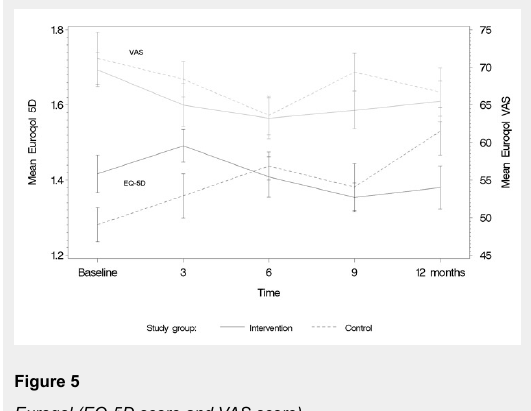
Euroqol (EQ-5D score and VAS